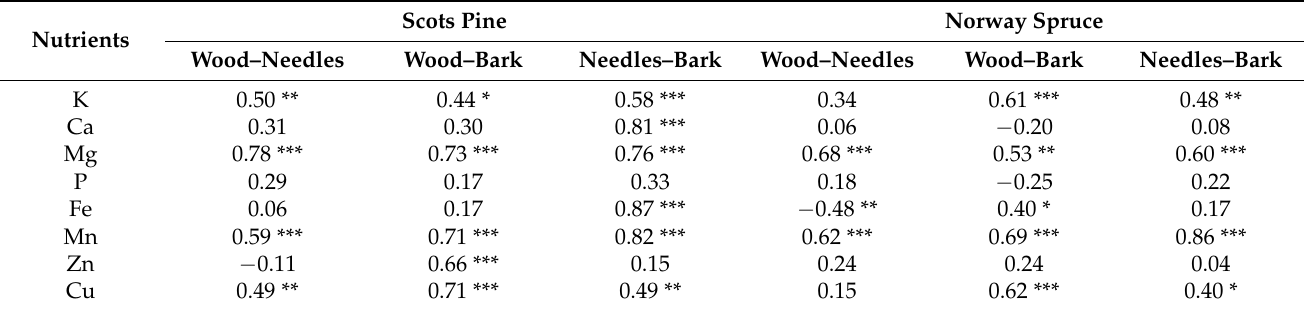
Table 2. Pearson’s correlation coefficients ( r ) for each element between plant organs.